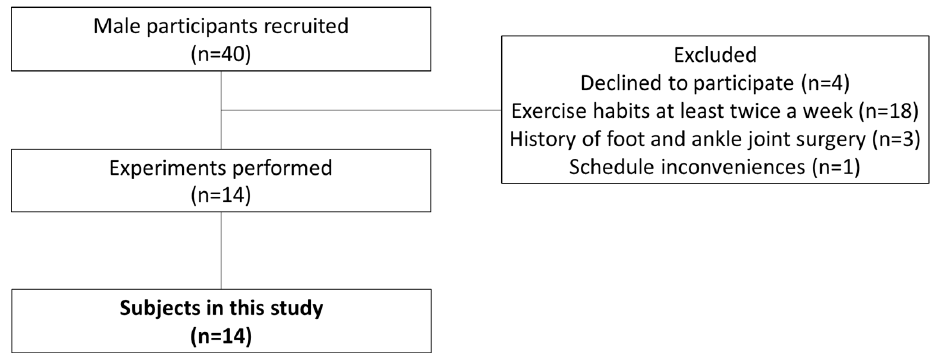
Figure 2. Flowchart for selection of male participants.